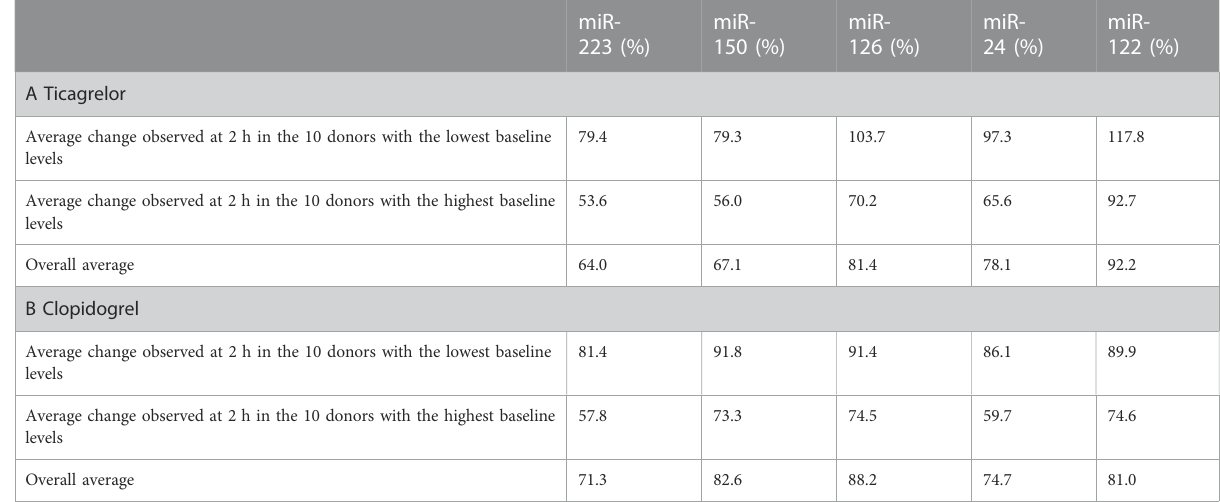
TABLE 2 Comparison of the relative change (2 h vs. baseline) between the donors with the highest and lowest baseline levels: (A) Ticagrelor treatment; (B) clopidogrel treatment. Values below 100% indicate a decrease of the respective miRNA 2 h after onset of platelet